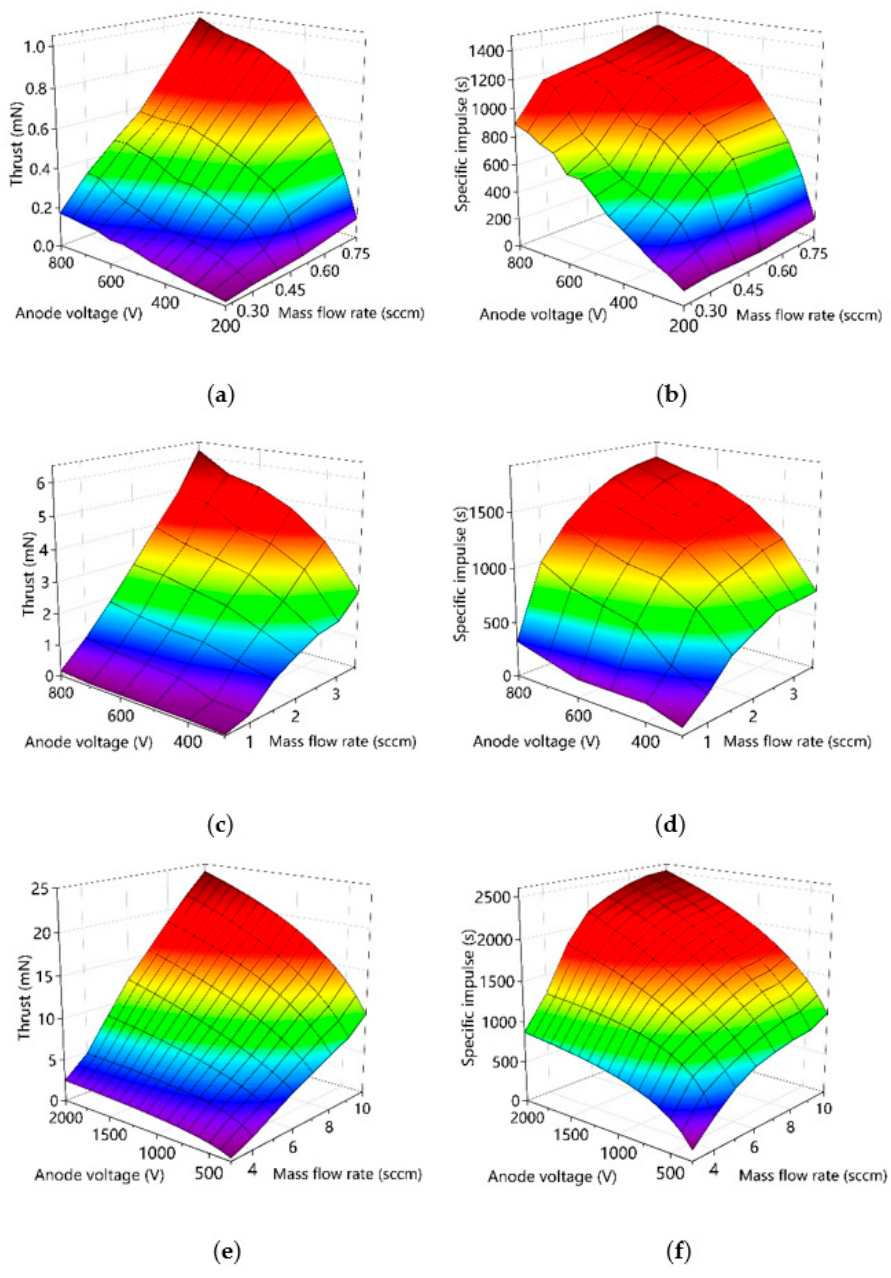
Figure 15. Thrust and specific operation spaces of thrusters with different diameters. ( a , b ) 6 mm, ( c , d ) 12 mm and ( e , f ) 24 mm.